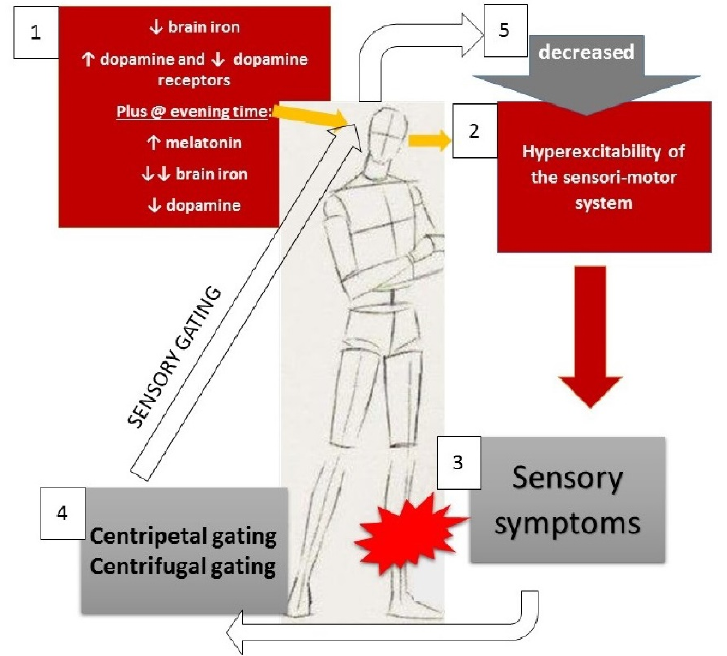
Figure 1. Proposed pathophysiological model for RLS. Centripetal gating is achieved by passive movements, massage, pressure, cold water, streaking, etc.; centrifugal gating is obtained by active movements. Arrows refer to increase/decrease of the mentioned compounds (“ ↑ ”: increase; “ ↓ ”: decrease; “ ↓↓ ”: substantial/consistent decrease.